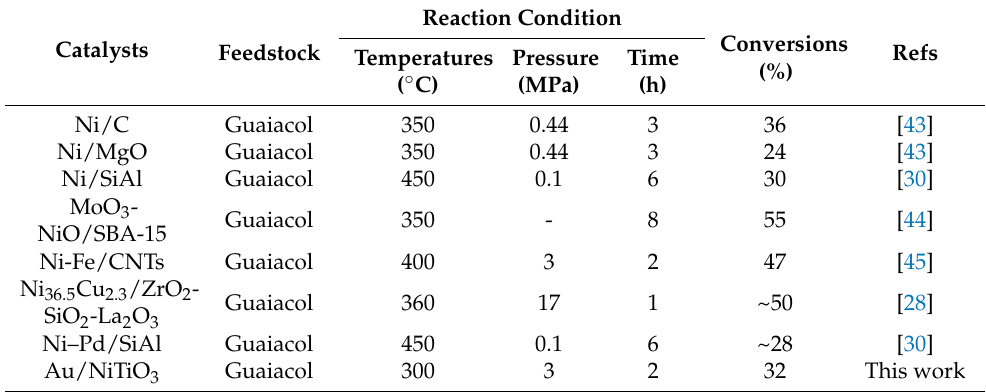
Table 2. Comparison of Ni-based catalysts for guaiacol